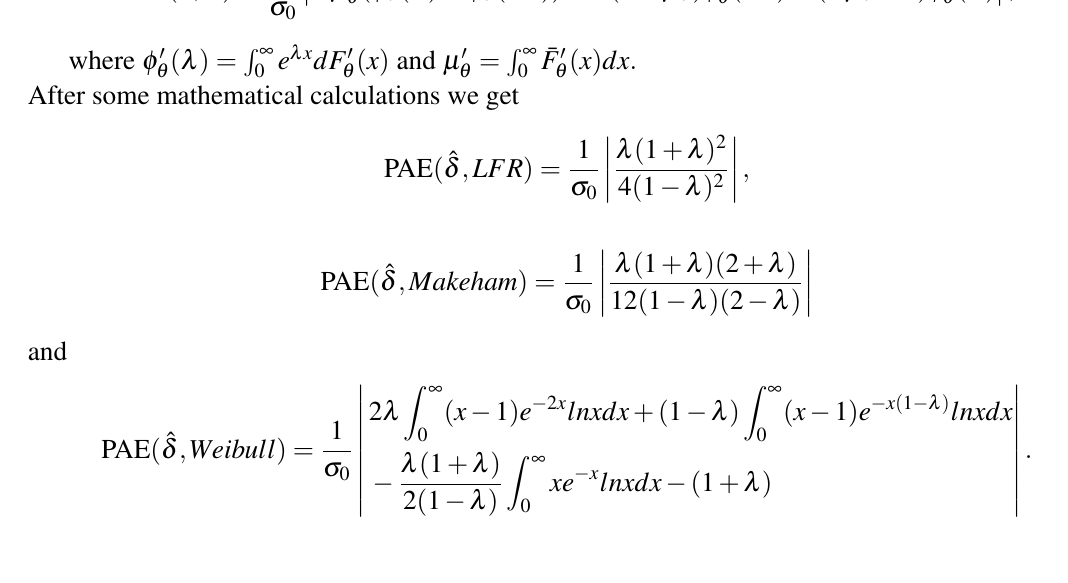
Table 1. Pitman asymptotic efficiencies for various values of